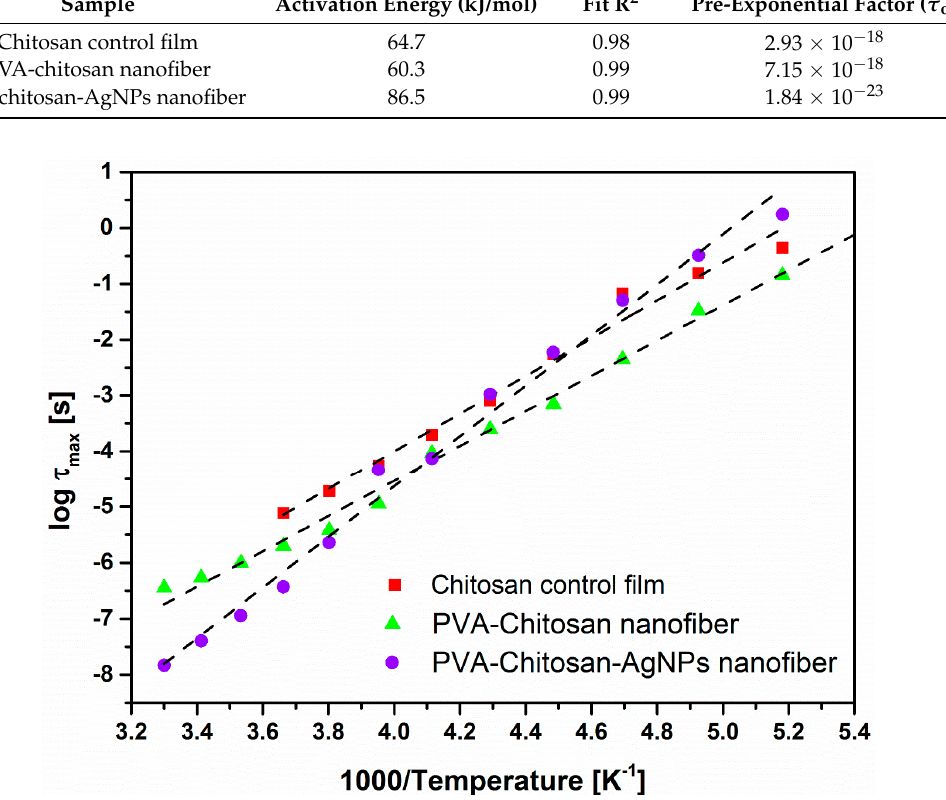
Figure 6. Arrhenius plots for the control chitosan film, electrospun chitosan/PVA and chitosan/PVA/AgNPs composite blends within the temperature range of Process I. Lines represent the best linear fits to the data.